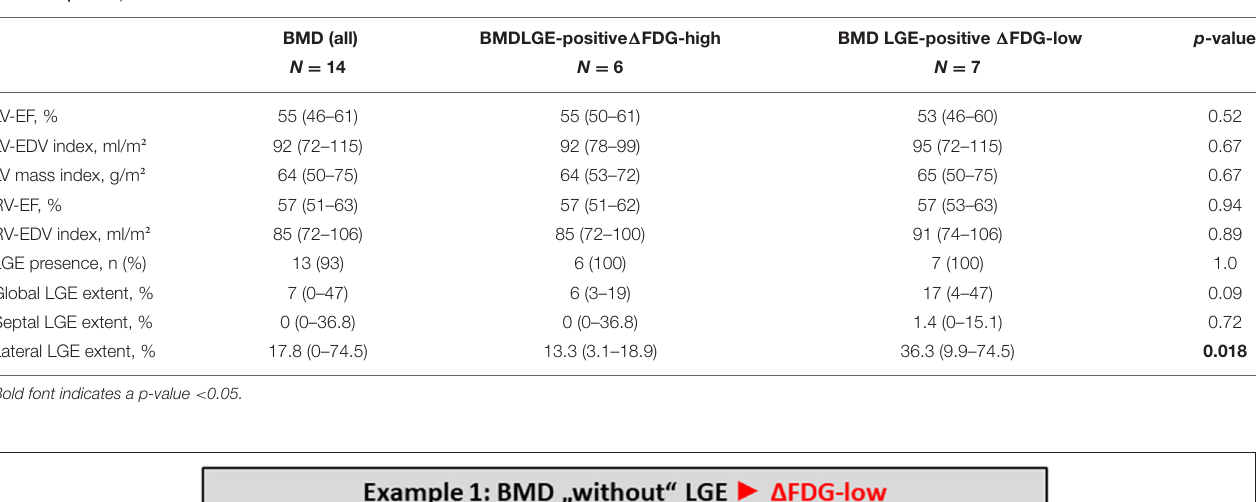
TABLE 2 | CMR parameters.